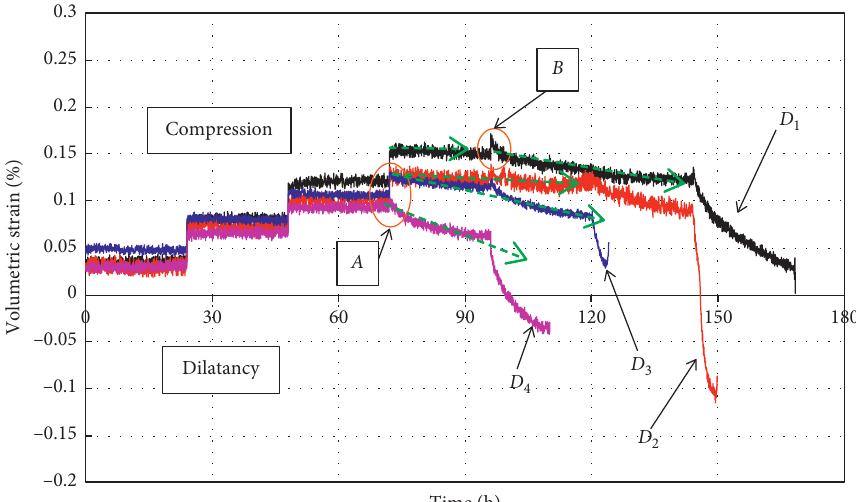
Figure 7: Volumetric strain curves of rock specimens with different initial damage in the creep tests.